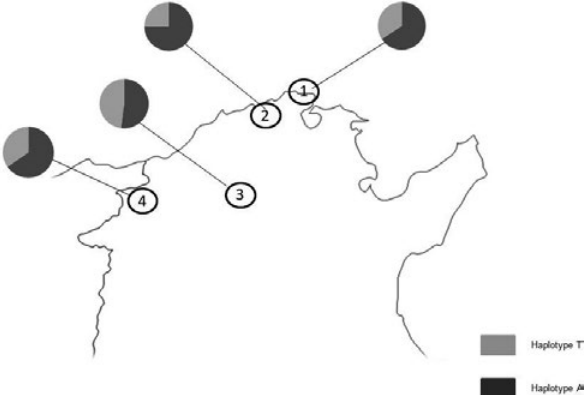
Figure 1. Map indicating sample sites in Tunisia where Fusarium isolates associated with root rot of wheat were obtained. Propor- tions (%) of haplotypes are indicated. Localities of Bizerte (1), Mateur (2), Beja (3) and Bousalem (4) are also